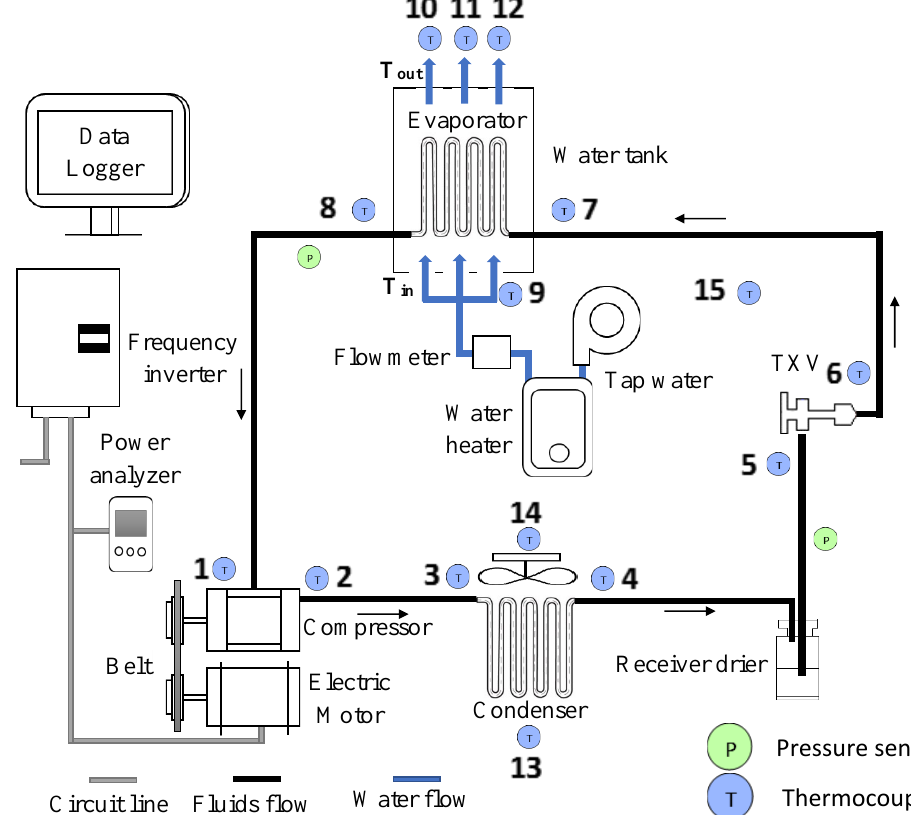
Figure 3. Schematic diagram of the AAC system.